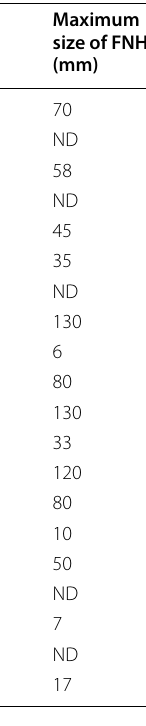
Table 1 Cases of liver transplantation for focal nodular hyperplasia